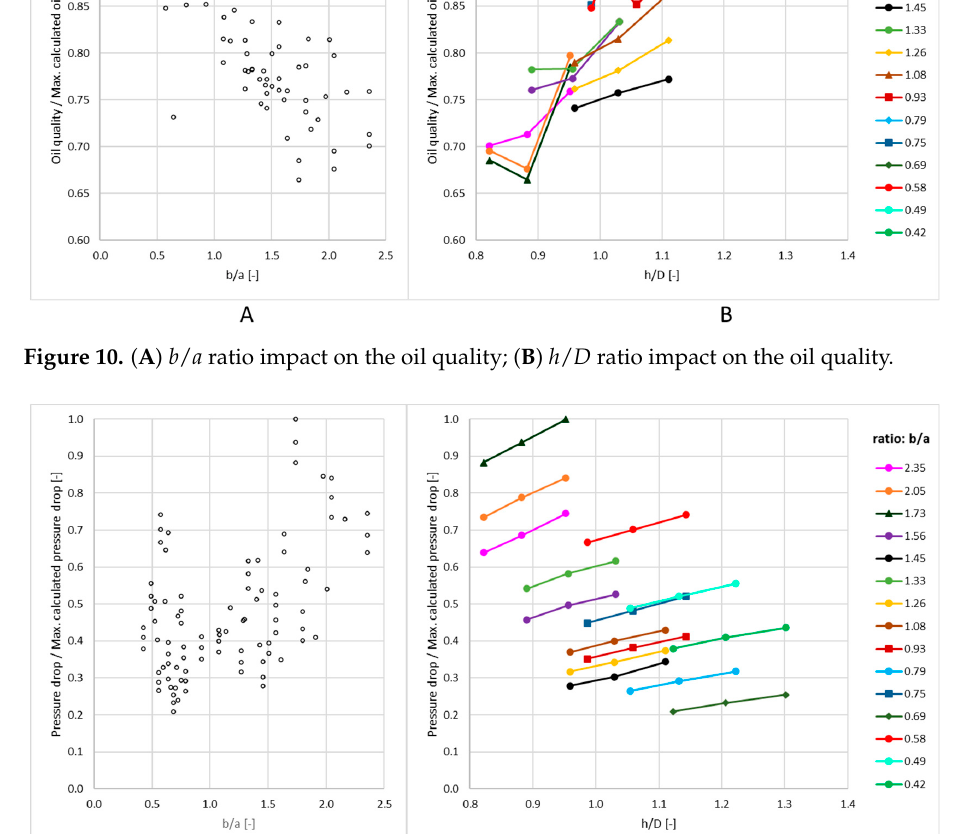
Figure 11. ( A ) Pressure drop vs. b/a ratio; ( B ) Pressure drop vs. the h/D ratio. From the presented numerical testing of the aircraft separator carried out at the set boundary conditions, it follows that: - The highest efficiencies are obtained for 𝑏/𝑎 (cid:3407) 1 and ℎ/𝐷 (cid:3408) 0.95 - The highest oil quality values are obtained for geometry with 𝑏/𝑎 (cid:3407) 0.6 and ℎ/𝐷 (cid:3408) 1.05 - An increase of 𝑏/𝑎 and decrease of ℎ/𝐷 ratios involves a higher pressure drop.